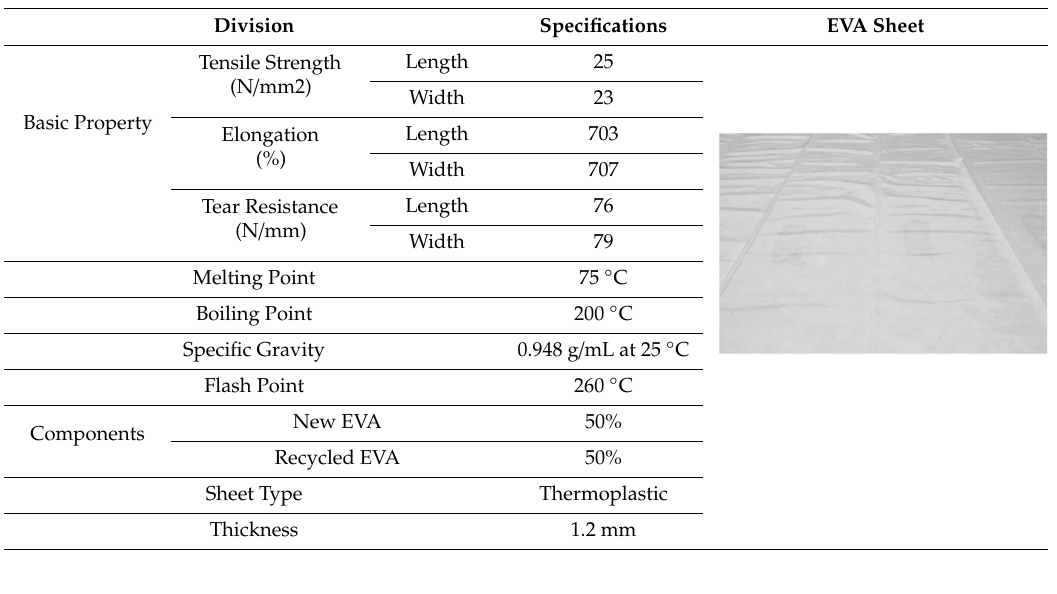
Table 4. EVA waterproofing sheet